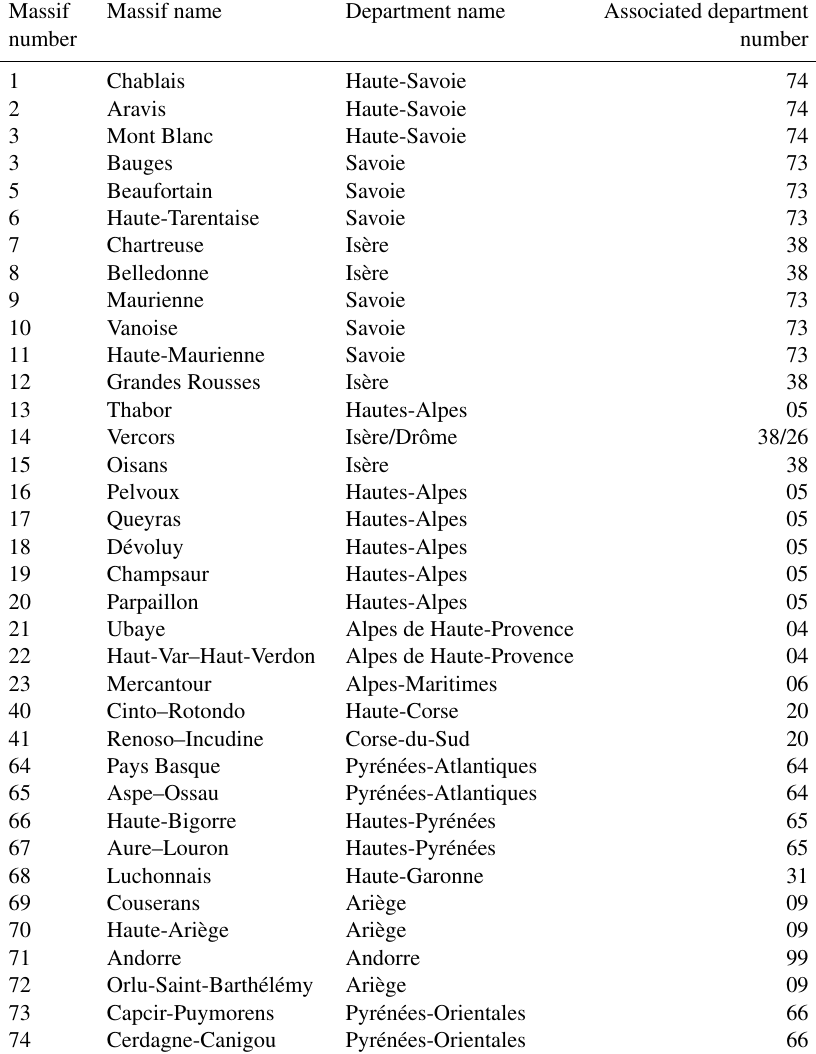
Table A1. List of massif numbers, massif names, and associated department names and department numbers (used for the evaluation) included in the S2M